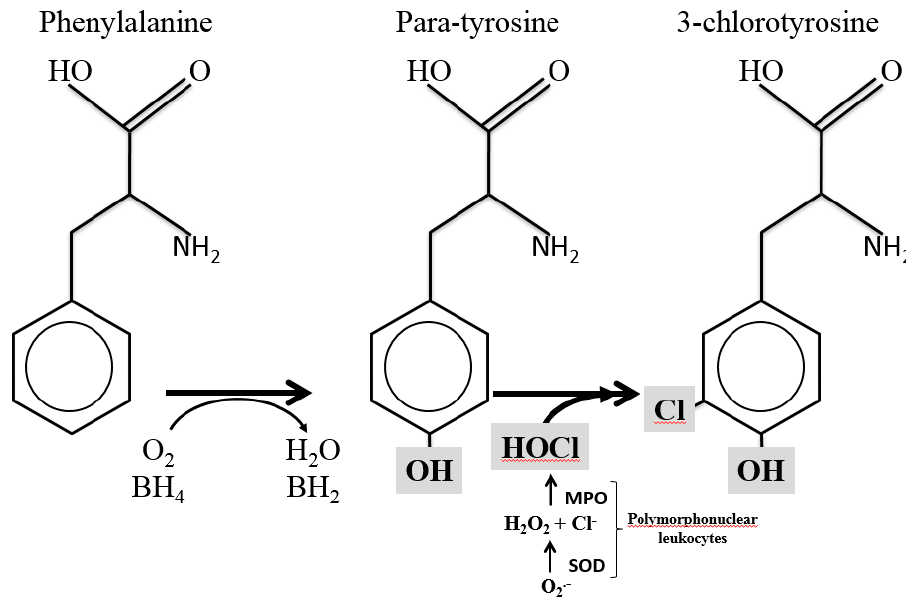
Figure 1. Synthesis of 3-chlorotyrosine. MPO = myeloperoxidase; H 2 O 2 = hydrogen peroxide; O 2 •− = superoxide; Cl − = chloride; SOD = Superoxide dismutase.